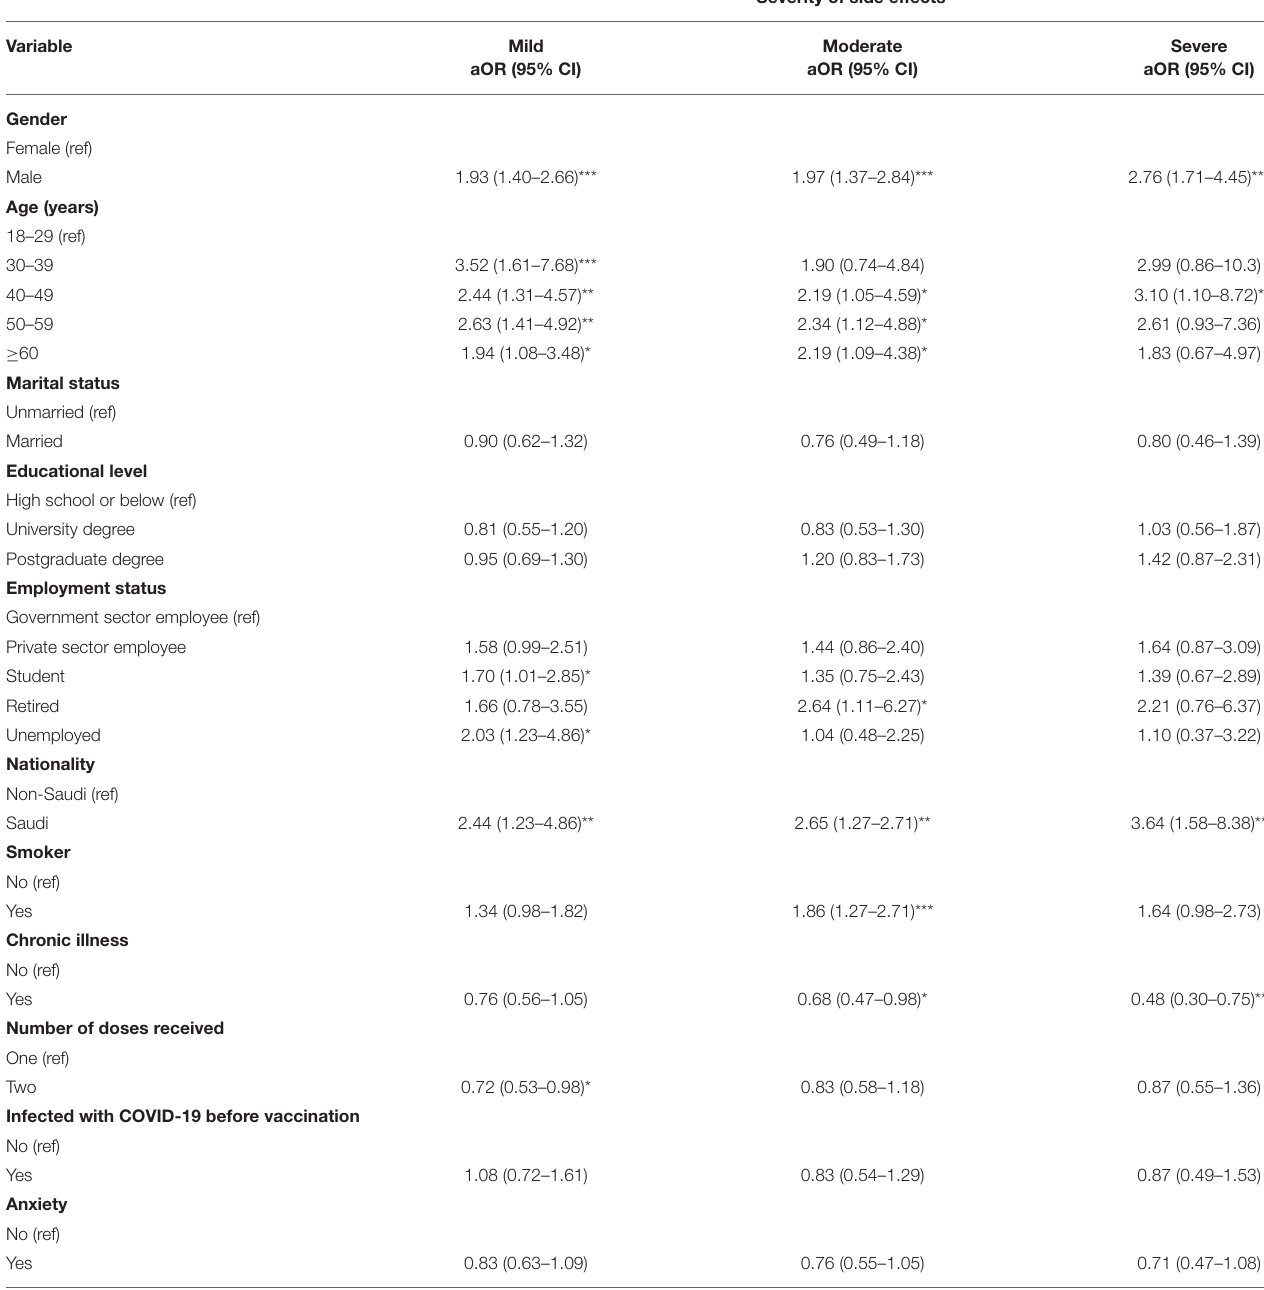
TABLE 5 | Logistic regression analysis results for the severity of side